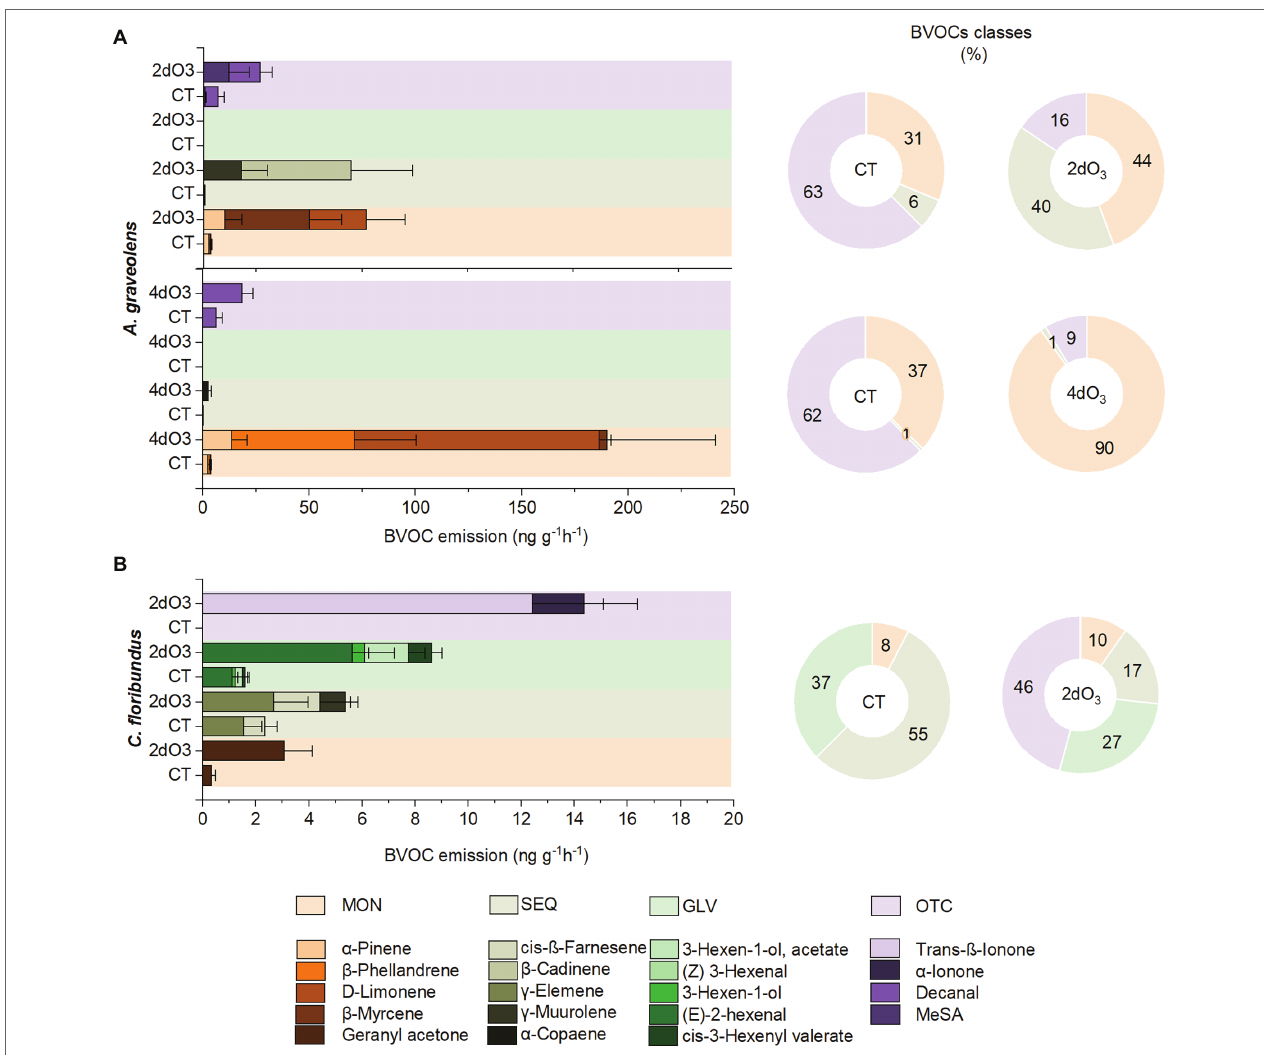
FIGURE 4 | Constitutive emission rates and percentage of different classes of BVOCs: MON, SEQ, GLV, and OTC in seedlings of (A) Astronium graveolens and (B) Croton floribundus exposed to CT and filtered air enriched with 80 ppb of ozone for 2 (2dO 3 ) and 4 days (4dO 3 ). Data are mean ± standard